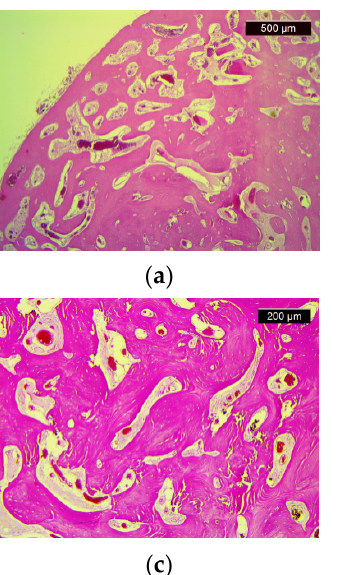
( i ) Figure 3. Patient III.2. Cephalometric ( a ) and panoramic ( b ) radiographs; CBCT axial ( c ), cross-section ( d ), panoramic ( e ), sagittal ( f ), coronal ( g ), 3D lateral-oblique ( h ) and 3D sagittal ( i ). In comparison, the male patient presented overall larger osteomas affecting the left angle of the mandible and both temporal bones, left coronoid process, impacted teeth, and increased bone sclerosis of the jaw bones. Additionally, a breast lipoma was observed in the male patient. Specific for this case is the presence of a pedunculated osteoma attached to the anterior wall of the right sphenoidal sinus and mucositis of the posterior ethmoidal